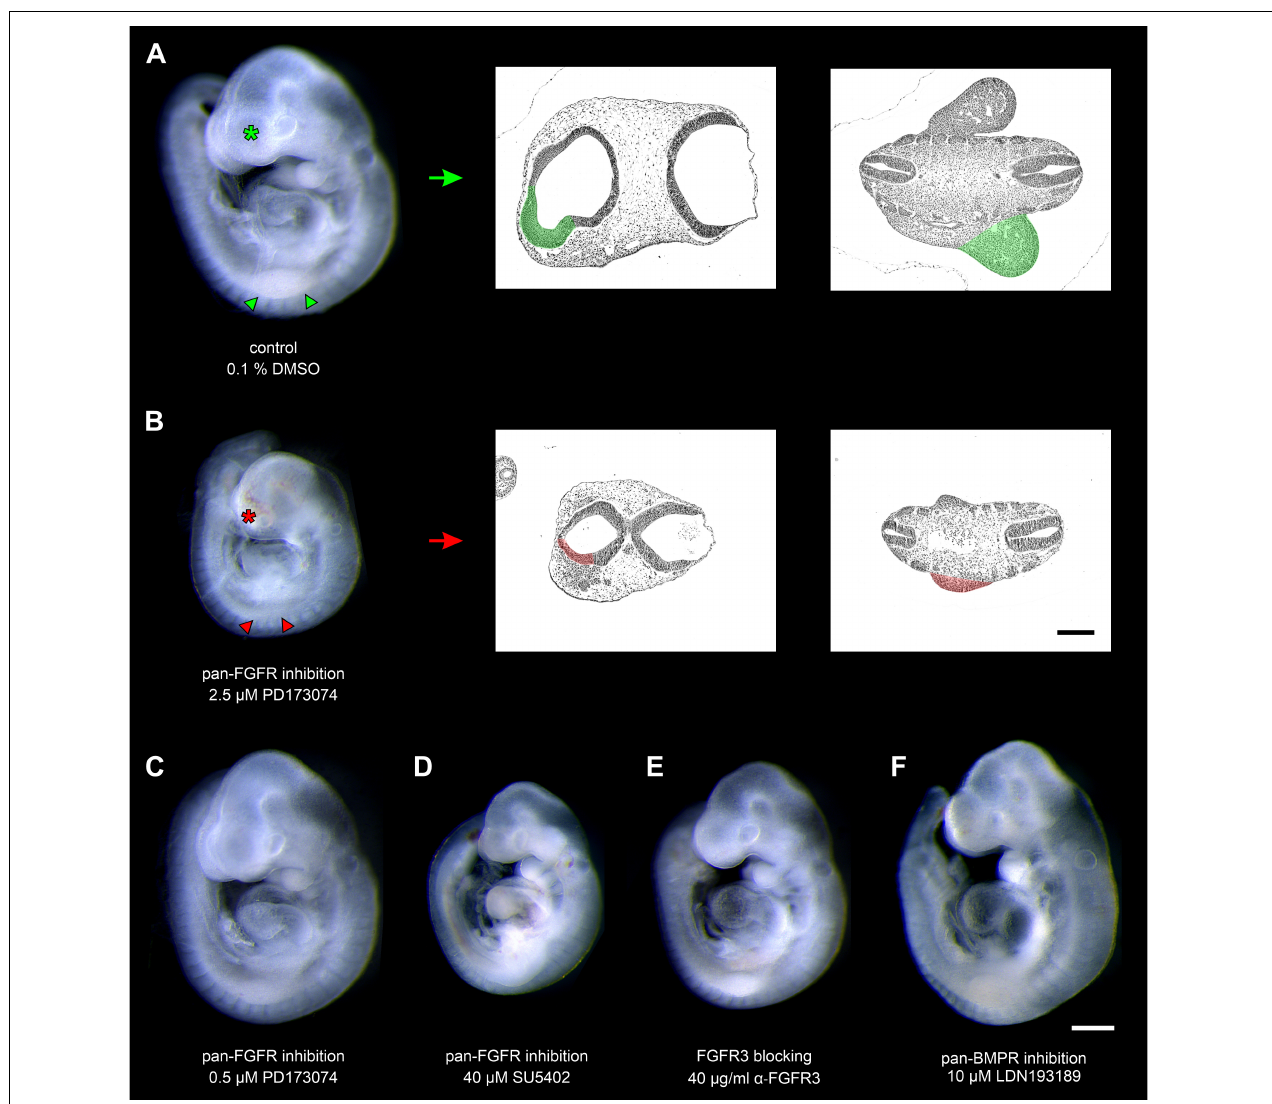
FIGURE 1 | Nine to fourteen somite mouse embryos, cultured for 24 h. (A) Control embryo, exposed to the solvent dimethyl sulfoxide (DMSO) only, reveals age-appropriate telencephalic hemispheres (green asterisk) and upper limb buds (green arrowheads); for comparison (green arrow), see corresponding hematoxylin stained histological sections (green colored areas). (B) Treatment with 2.5 µ M of the pan-FGFR inhibitor PD173074 considerably impairs the development of telencephalic hemispheres (red asterisk) and upper limb buds (red arrowheads); for comparison (red arrow), see corresponding hematoxylin stained histological sections (red colored areas). (C) Application of 0.5 µ M PD173074 did not cause any obvious abnormalities. (D) Embryos incubated with 40 µ M of the pan-FGFR inhibitor SU5402 exhibit general growth disturbances (also see Table 1 ). (E,F) Treatment with 40 µ g/ml of anti-FGFR3 neutralizing antibodies or 10 µ M of the pan-BMPR inhibitor LDN193189 were well tolerated. Scale bars: 500 µ m for stereomicrographs (A–F) , 200 µ m for light micrographs (A,B)